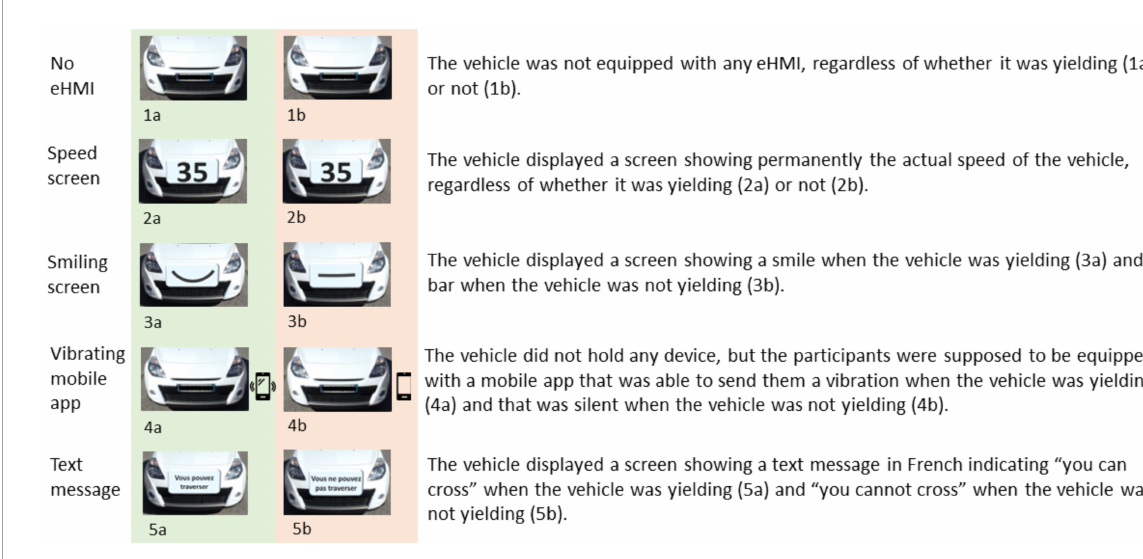
FIGURE1 The different types of eHMI signals used in the experiment.